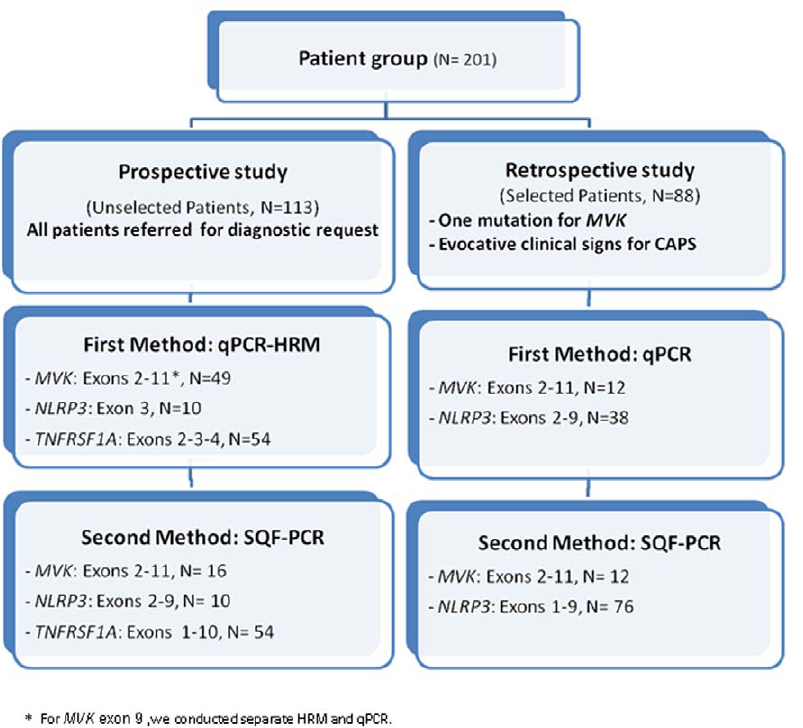
Figure 1. Flow chart for the screening of mutations in the genes MVK , NLRP3 and TNFRSF1A . In our patient cohort, we performed a simultaneous search for punctual mutations and gene rearrangements using qPCR-HRM in the prospective group and qPCR alone in the retrospective group (as these patients had already been assessed for qualitative alterations), then SQF-PCR in both groups as a confirmatory quantitative approach. doi:10.1371/journal.pone.0014096.g001 PLoS ONE |